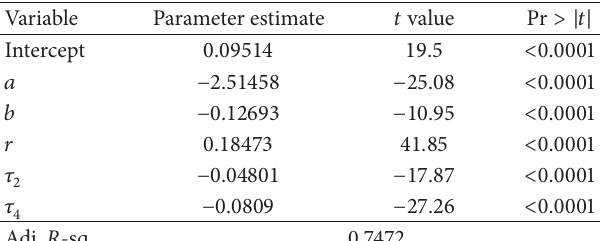
Table 8: Statistics of multiple linear regression for selected sampling